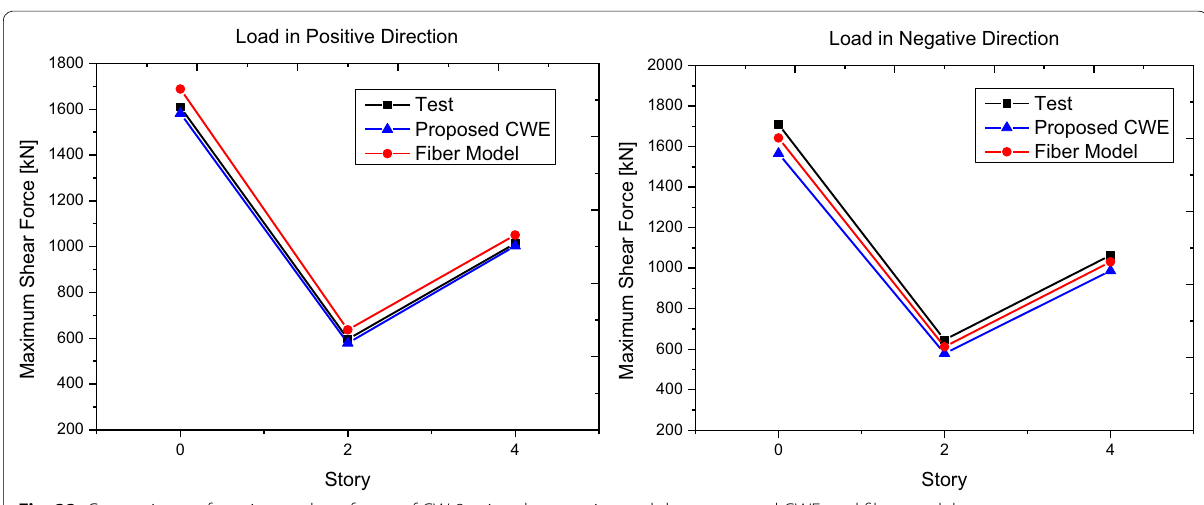
Fig. 22 Comparisons of maximum shear forces of CW-2 using the experimental data, proposed CWE, and fiber